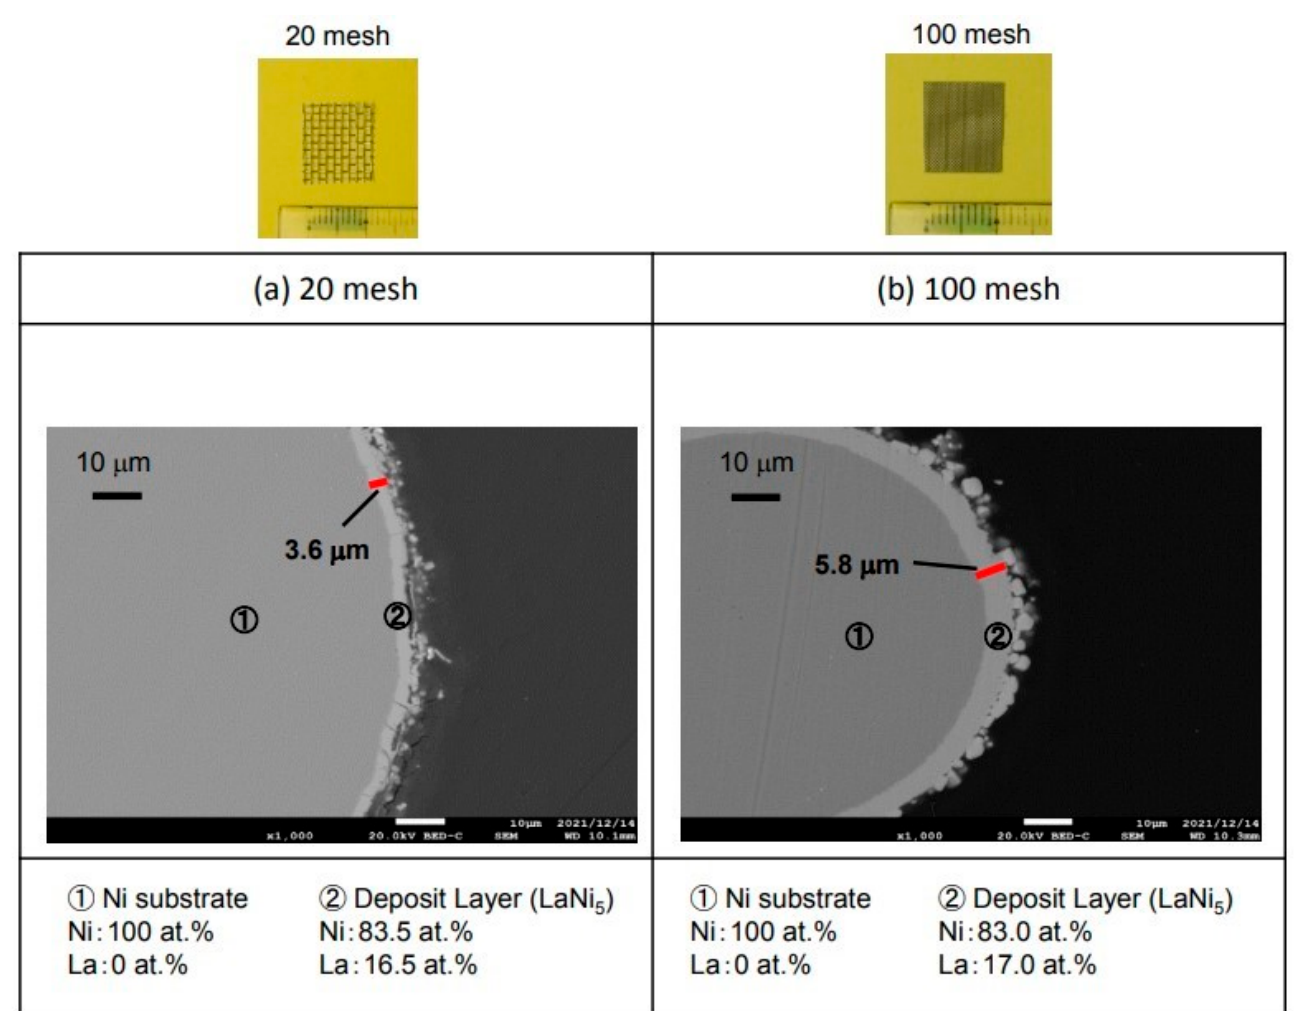
Figure 11. Cross-sectional microstructure and element analysis of Ni mesh after La deposition at − 2.25 V in NaCl-KCl-5.0 mol%LaF 3 melts at 750 °C.